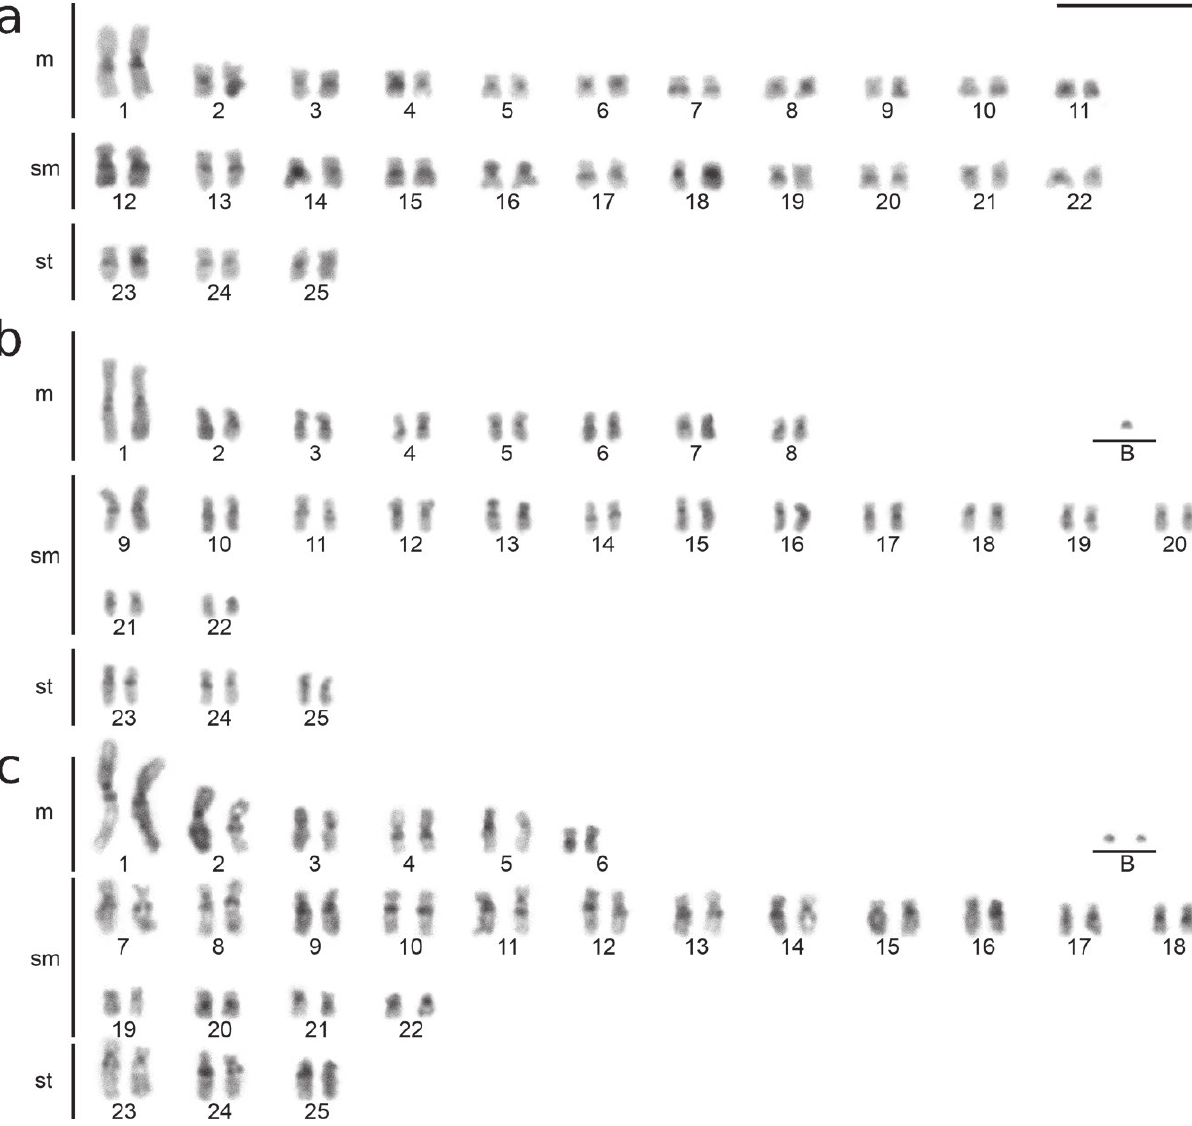
Figure 2. C-banded chromosomes of (a) Moenkhausia dichroura , (b) M. intermedia and (c) M. sanctaefilomenae